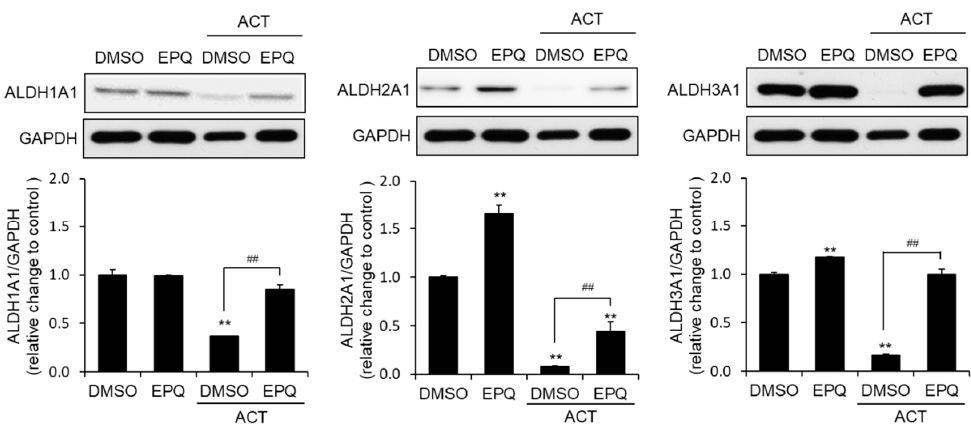
Figure 5. E ff ect of EPQ on the expression of ALDH-related proteins in acetaldehyde-treated PC12 cells. Cells were treated with DMSO (0.5%, v / v ) or EPQ (20 µ M) in the presence and absence of acetaldehyde (500 µ M) for 24 h. The oxidative stress-related protein levels of ALDH1A1, ALDH2A1, and ALDH3A1 were determined by the western blots. GAPDH was a loading control. All values are expressed as mean ± SEM ( n = 3; ** p < 0.01 compared to the DMSO control group and ## p < 0.01 compared to the group treated only with ACT). EPQ, ent -peniciherqueinone; DMSO, dimethyl sulfoxide; GAPDH, glyceraldehyde 3-phosphate dehydrogenase; ALDH, aldehyde